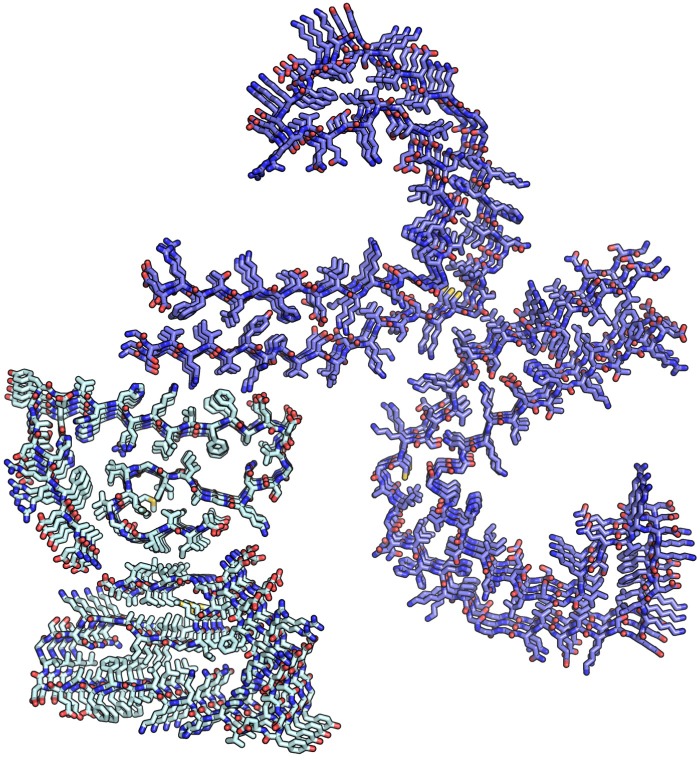
Hetero-seeding model from side of Aβ fibril.Residues 16–21 of Aβ (5OQV) were superimposed on 304–309 of Tau (6HRF). Tau was then manually moved perpendicular to the fibril axis to make a complementary surface with 5OQV. Backbone and side chain rotamers were optimized with Foldit to minimize energy to −1517REU.